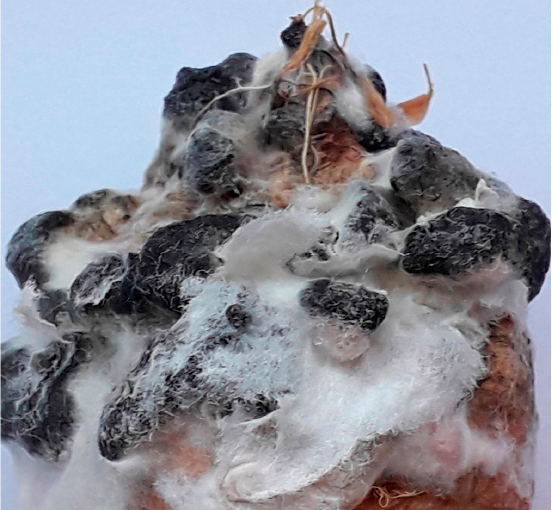
Figure 4. Mycelium and sclerotia of Sclerotinia sclerotiorum on the scorzonera root (scale 3:1); (photo by E. Patkowska).